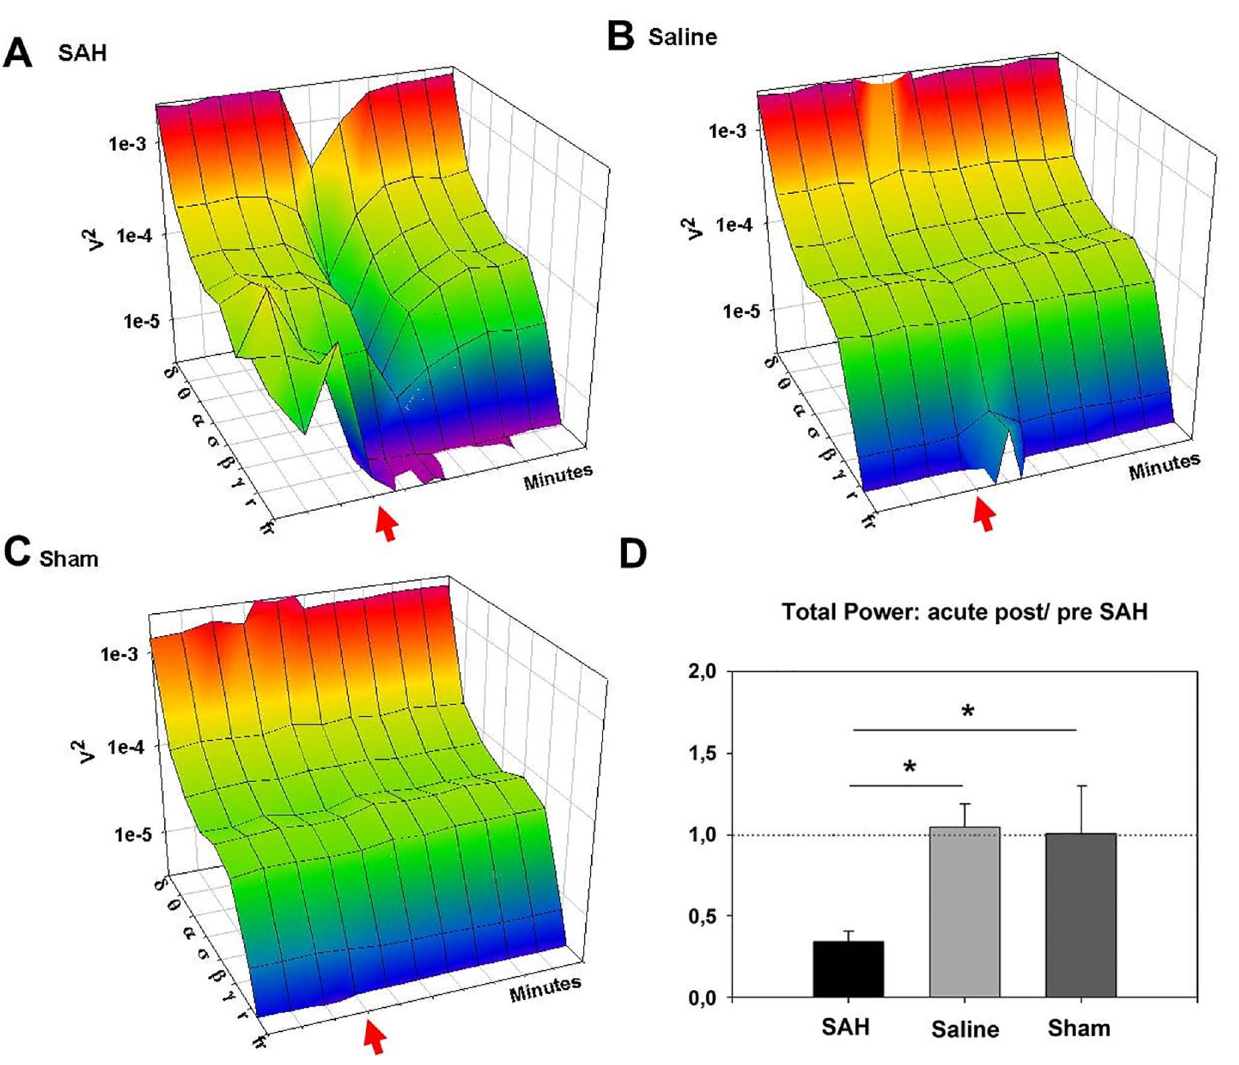
Fig. 4. ECoG spectrum following SAH, saline and sham injection. Fig. 4 depicts the effect of the three experimental conditions on the ECoG spectrum. A: power spectrum of the SAH group. Injection of blood causes a drastic reduction of absolute power of almost all frequency bands lasting several minutes. Fast ripples were not detectable before SAH, but emerge instantly thereafter. B: power spectrum of the saline-injected group. C: power spectrum of the sham-injection group. Fast ripples were not detectable in saline or sham injected groups. D: Total ECoG power was significantly reduced in the SAH group by an average of